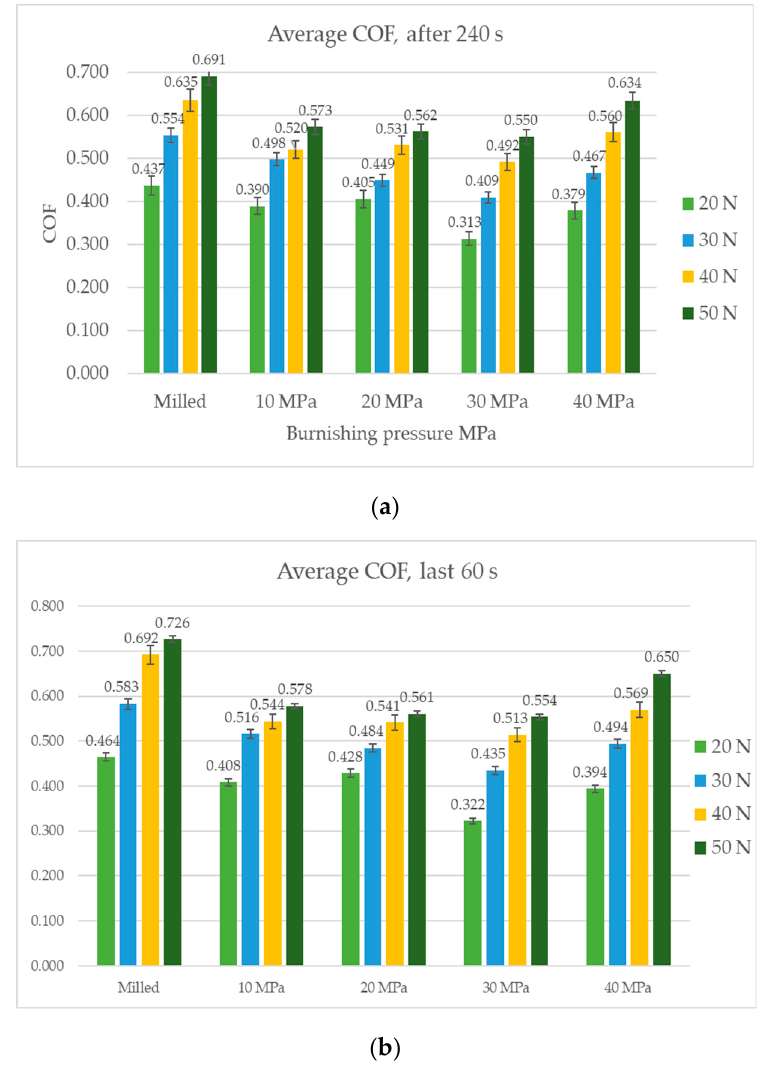
Figure 6. The average coefficient of friction after 240 s ( a ), and for the last 60 s ( b ).